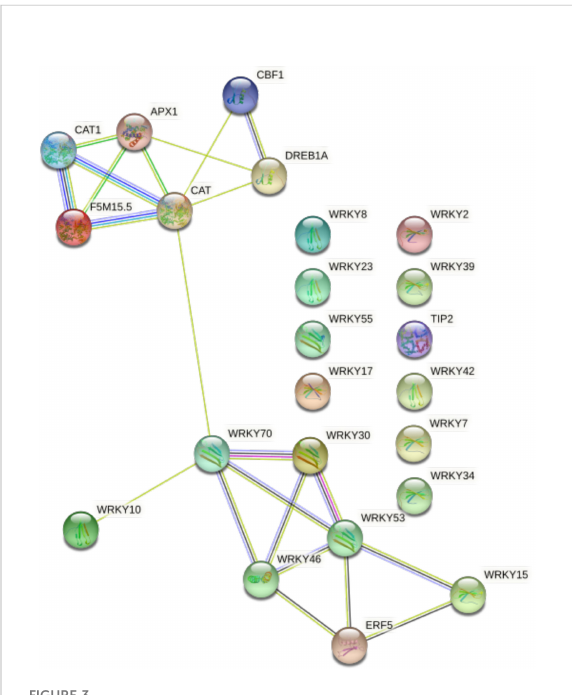
FIGURE 3 The interaction network analysis of some WRKY genes identi fi ed in Arabidopsis thaliana using STRING: Line colors are associated with interaction types. Around the green line gene, pink lines are experimentally determined, black lines mean co-expression, dark blue lines mean gene co-occurrence, and blue lines mean protein